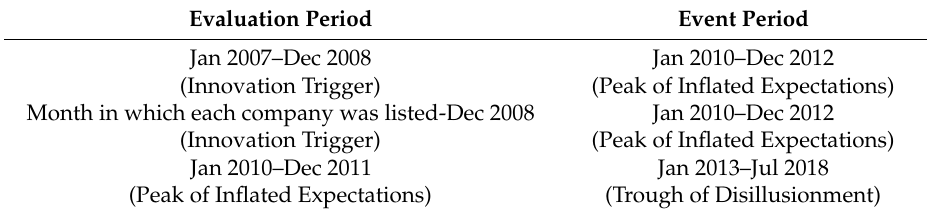
Table 1. Average cumulative abnormal returns (CAR) analysis